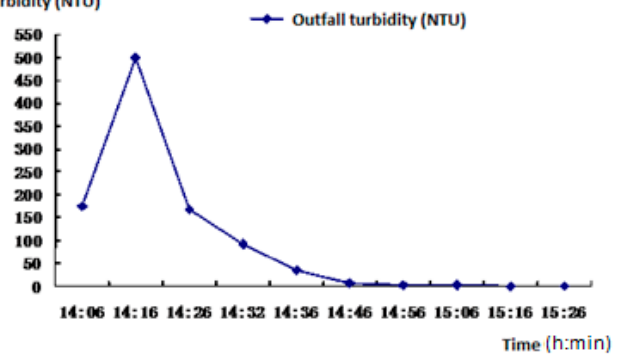
Figure 31. Data record of turbidity during the flushing cleaning process.